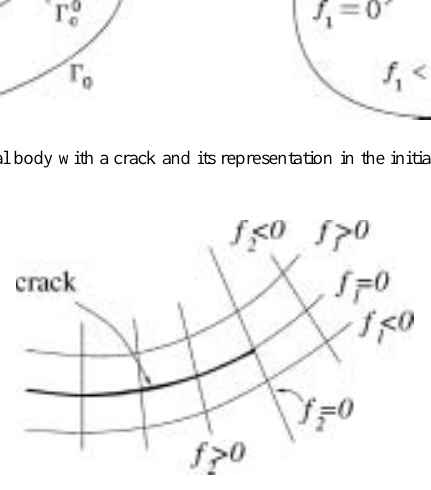
Fig. 2. A two dimensional crack represented by two sets of implicit function f 1 and f 2